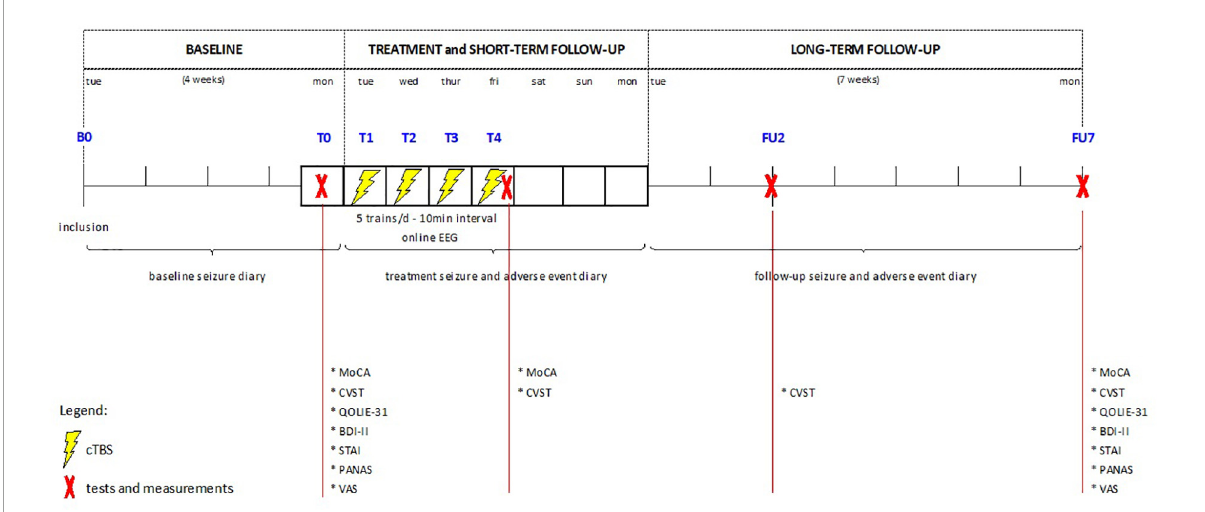
FIGURE1 Overview of study design. cTBS, continuous theta burst stimulation; EEG, electroencephalography; MoCA, Montreal Cognitive assessment; CVST, comuterized visual searching task; QOLIE-31, quality of life in epilepsy-31; BDI-II, Beck depression inventory version II; STAI, state-trait anxiety inventory; PANAS, positive affect negative affect scale; VAS, visual analogue